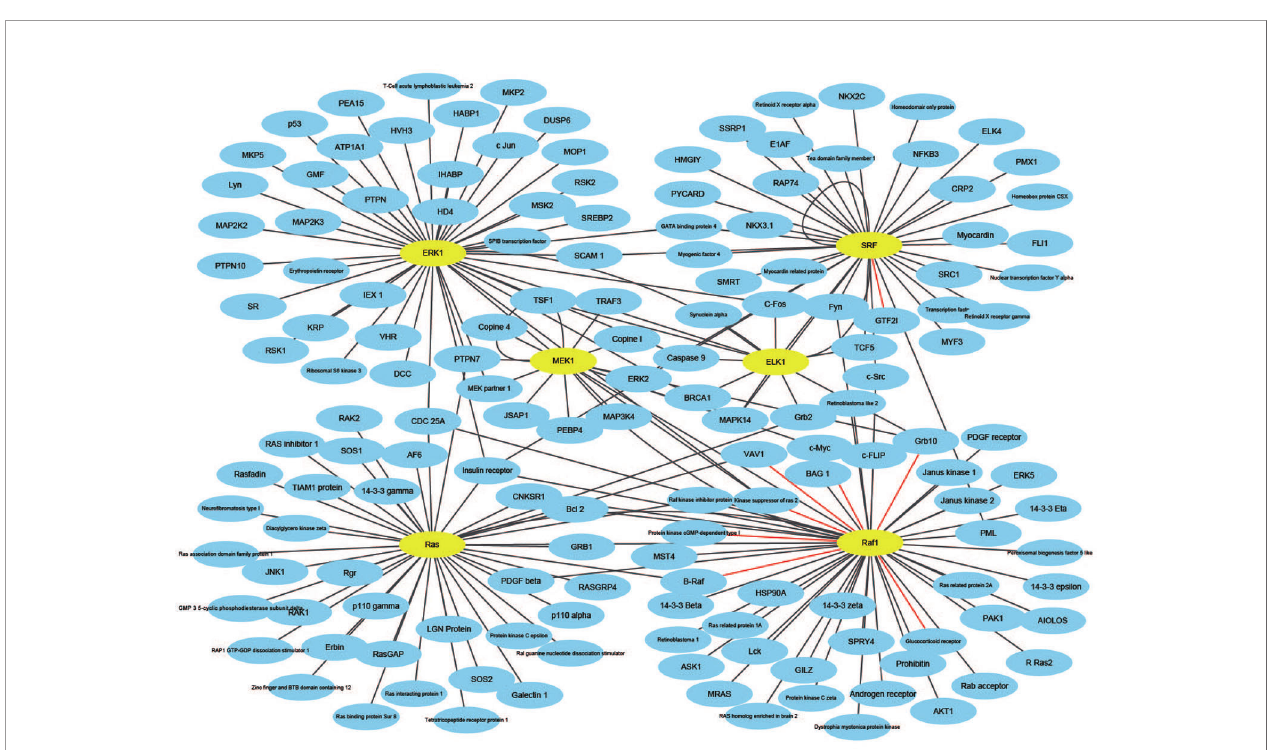
FIGURE 7 | The prediction results of multi-core network of Ras-Raf-Mek-Erk-Elk-Srf